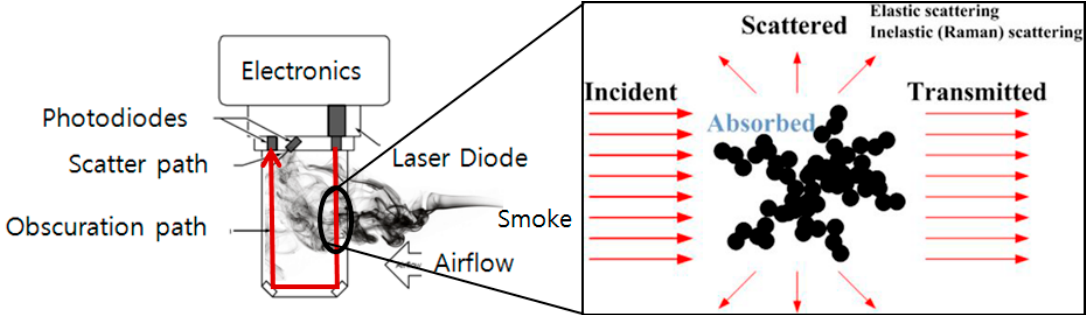
Figure 10. Schematic diagram of smoke detector installed onboard the Destiny module. To detect the signals of smoke particles generated by a fire, the FDS provides a smoke detector function and generates alarm signals using a method similar to the abovemen- tioned method. The soot mass fraction of each calculation grid is predicted based on the calculated flow field data and the input soot yield in proportion to the mass loss after ignition of the combustible, and the light transmittance ( I ) is calculated using Equation (11) in conjunction with the input mass extinction coefficient as follows: